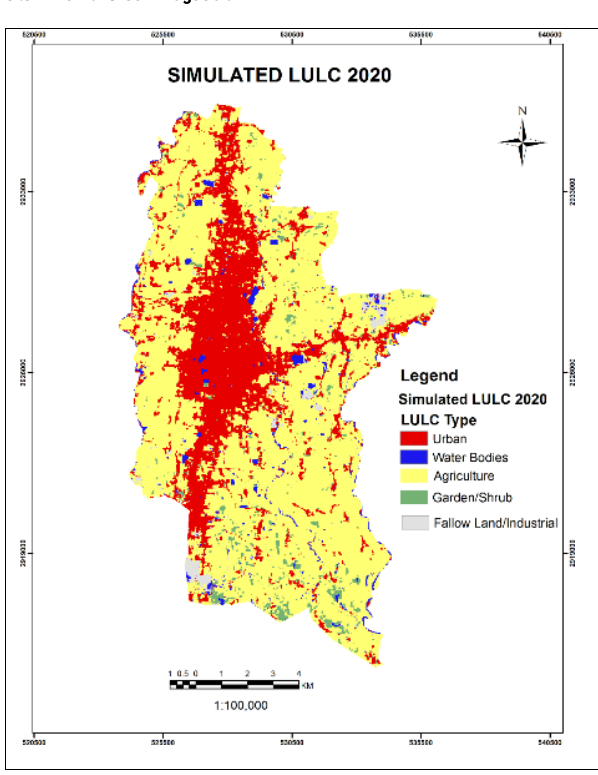
Figure 3. projected land use land cover map of